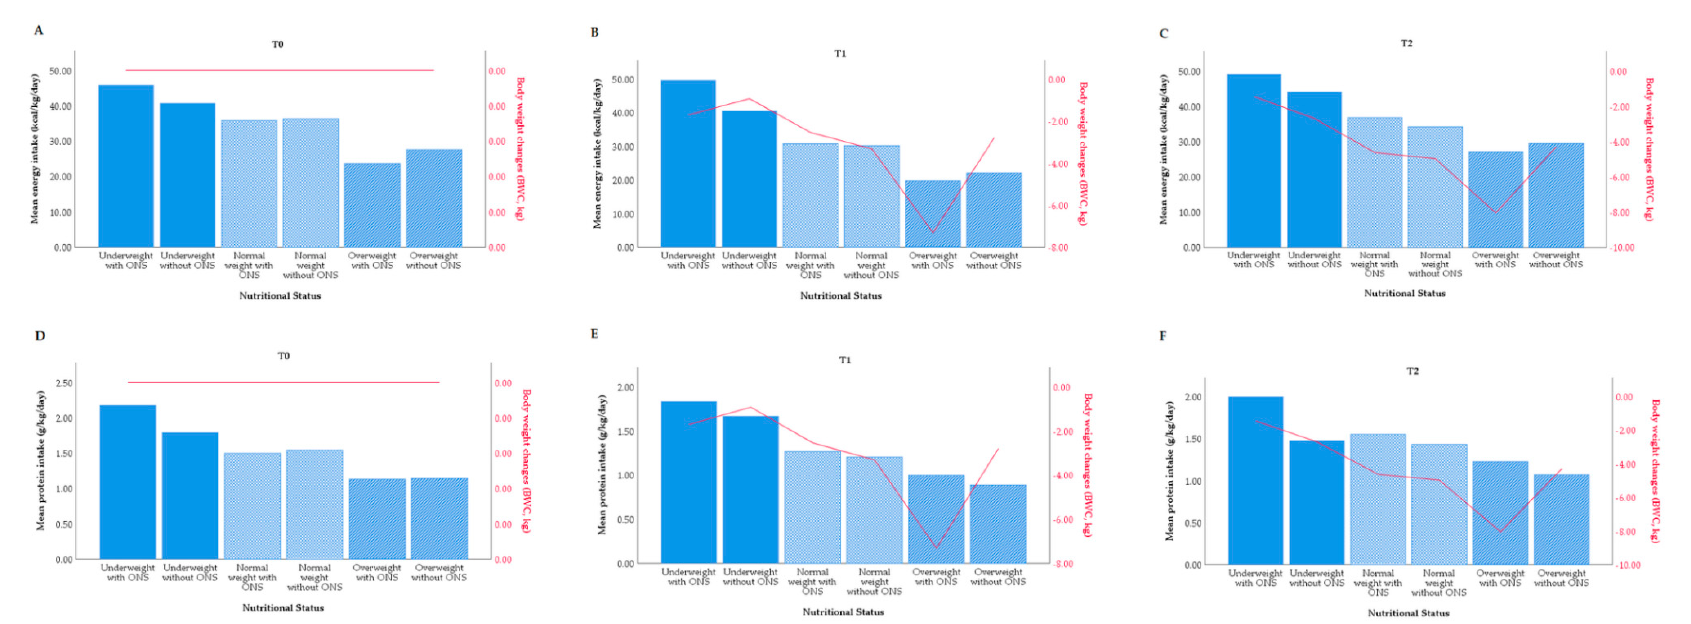
Figure 2. Mean energy and protein intake and BWC by nutritional status. ( A ) Mean energy intake and BWC considering three time points by nutritional status in T0. ( B ) Mean energy intake and BWC considering three time points by nutritional status in T1. ( C ) Mean energy intake and BWC considering three time points by nutritional status in T2. ( D ) Mean protein intake and BWC considering three time points by nutritional status in T0. ( E ) Mean protein intake and BWC considering three time points by nutritional status in T1. ( F ) Mean protein intake and BWC considering three time points by nutritional status in T2. Abbreviations: BWC, body weight changes; ONS, oral nutritional supplementation.